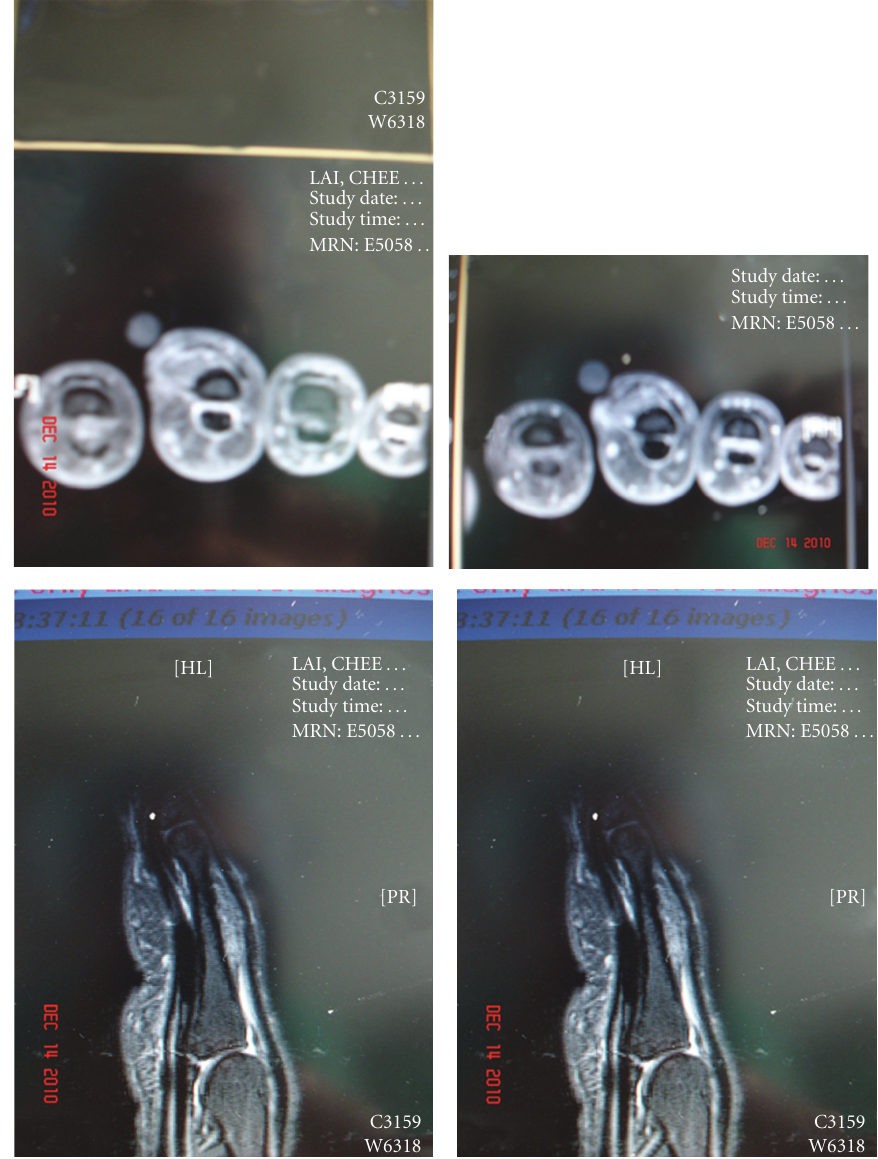
Figure 4: Axial and sagittal FSE T1W, FS T2W, and FS T1W images of the middle finger. There is a heterogenous soft tissue lesion in the radial and extensor aspect of the shaft of proximal right middle finger, measuring 1 . 0 × 0 . 7 × 1 . 8 cm (cross section × long) in size. This lesion is T1W hypointense, T2W heterogeneously hyperintense with some enhancement. This lesion is located underneath the extensor tendon with elevation of the tendon. The extensor tendon is intact and elevated by the mass.